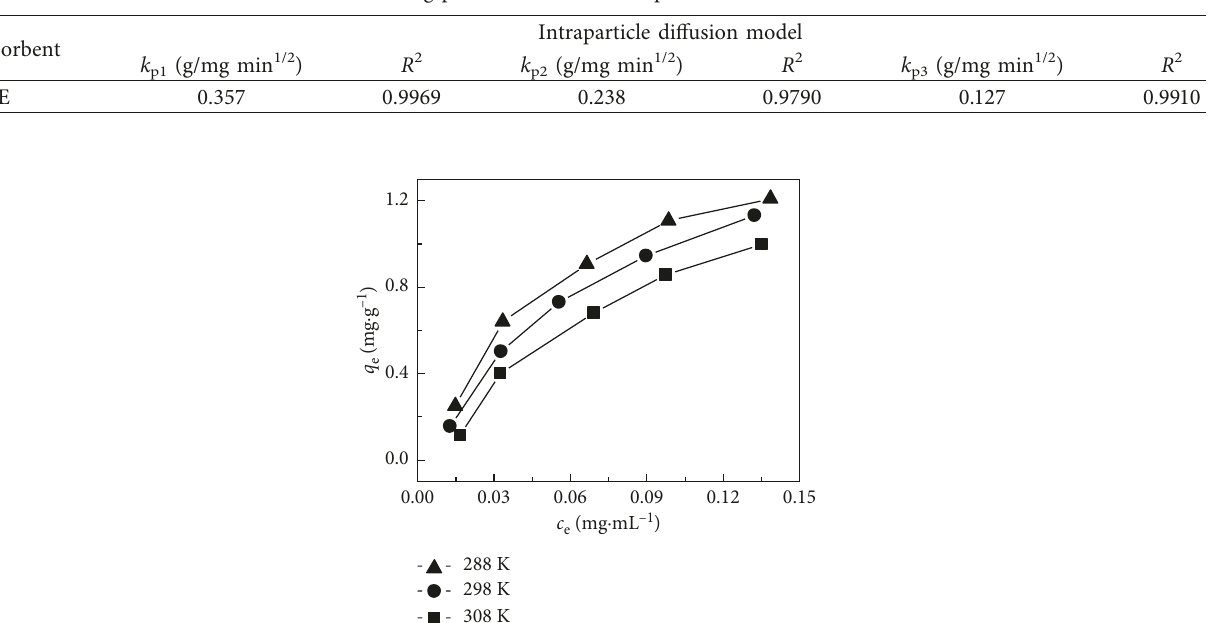
Table 2: Fitting parameters of the intraparticle diffusion model.